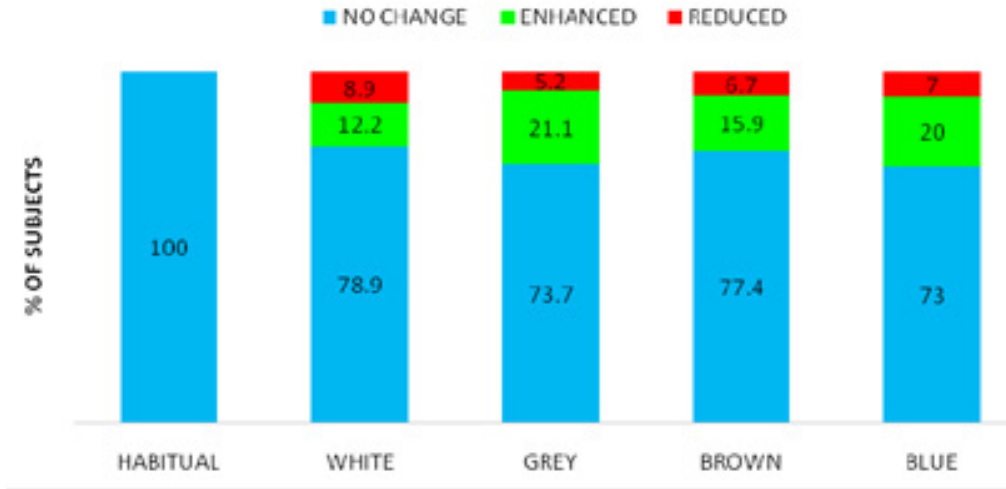
Figure 5: The effect of tinted spectacle lenses on results from the colour vision test that was applied